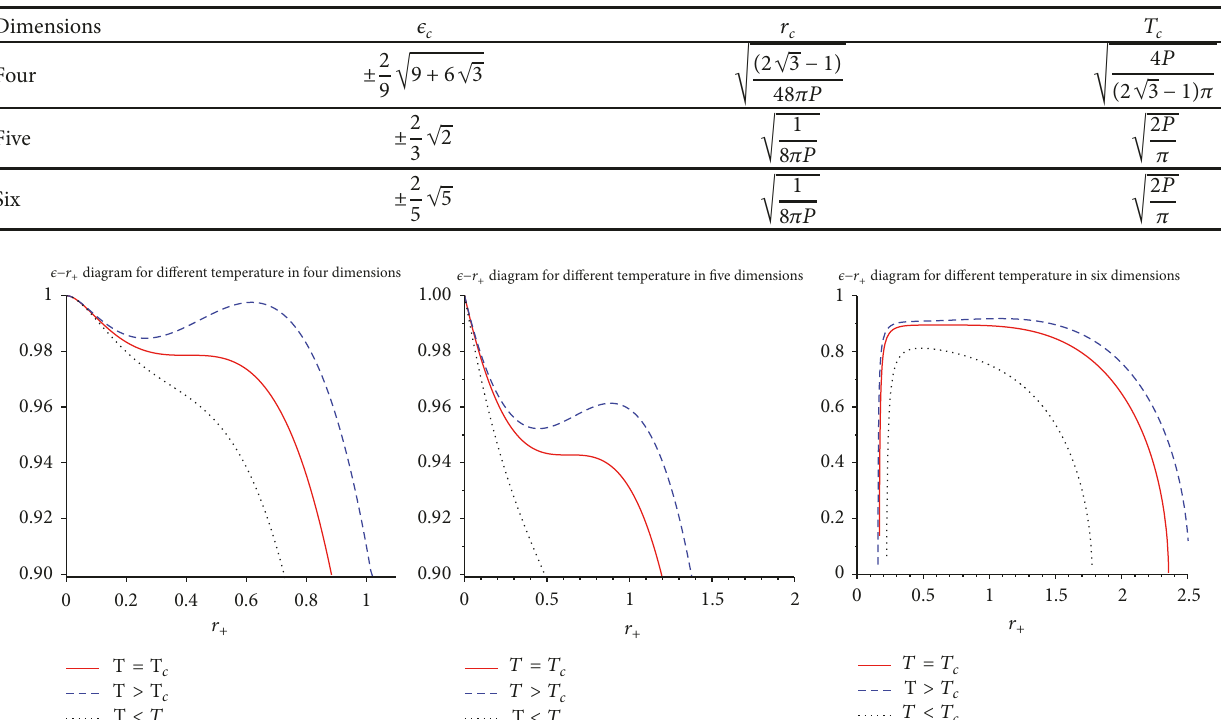
Figure 6: Curves of 𝜖 − 𝑟 + with 𝑃 = 1/10 in four, five, and six dimensions for different temperature. In four and five dimensions, one can observe the 𝜖 − 𝑟 + oscillatory behavior when 𝑇 > 𝑇 𝑐 , while no oscillatory behavior for six dimensions is